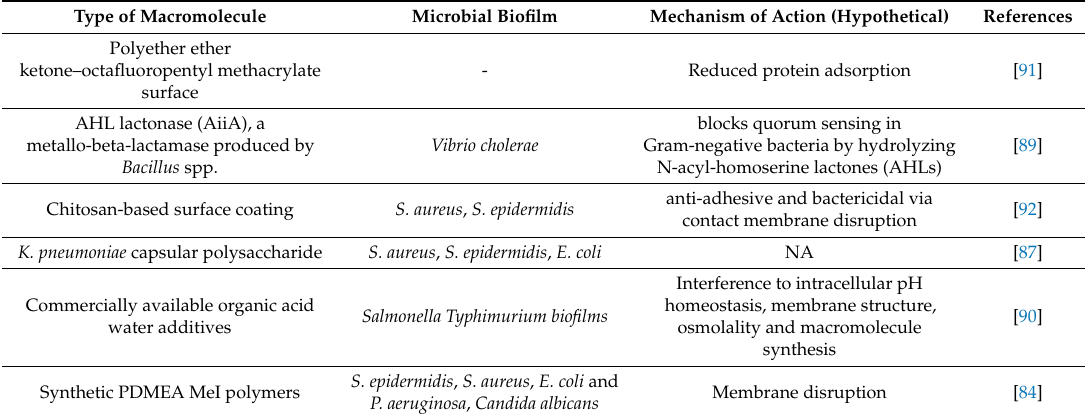
Table 7. Examples of biomacromolecules with anti-biofilm